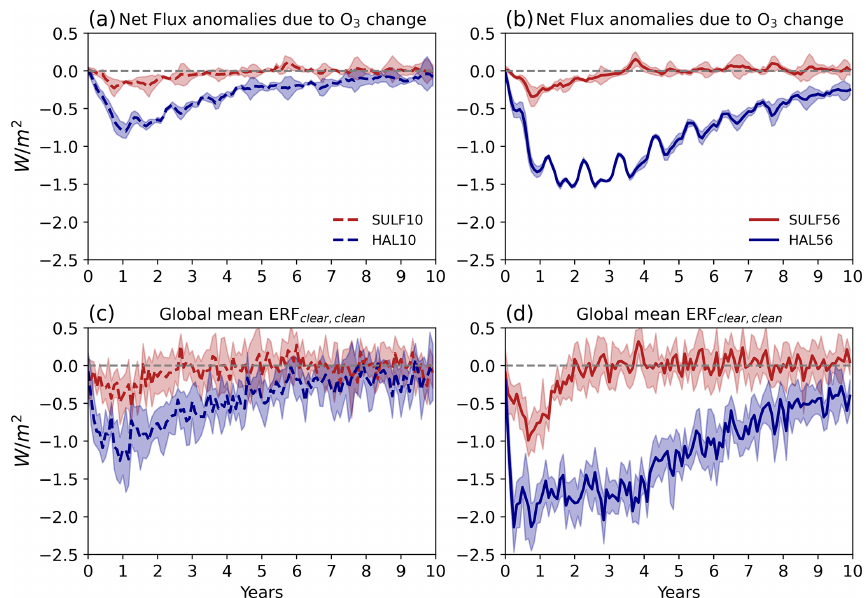
Figure 9. Evolution of global-mean top-of-atmosphere net flux anomalies due to stratospheric O 3 change estimated from the ozone radiative kernel from Rap et al. (2015) in SULF10 and HAL10 (a) and in SULF56 and HAL56 (b) . Evolution of the global-mean top-of-atmosphere compositional forcing (ERF clear , clean ) in SULF10 and HAL10 (c) and in SULF56 and HAL56 (d) . Ozone changes make up ∼ 75% of the ERF clear , clean . Shading represents the ensemble range.